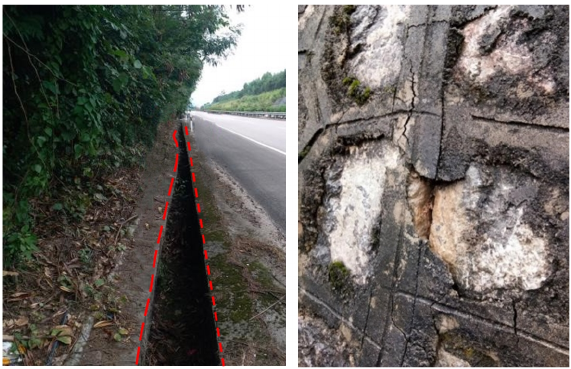
Figure 3. Gutter extrusion deformation ( left ); retaining wall cracking ( right ).